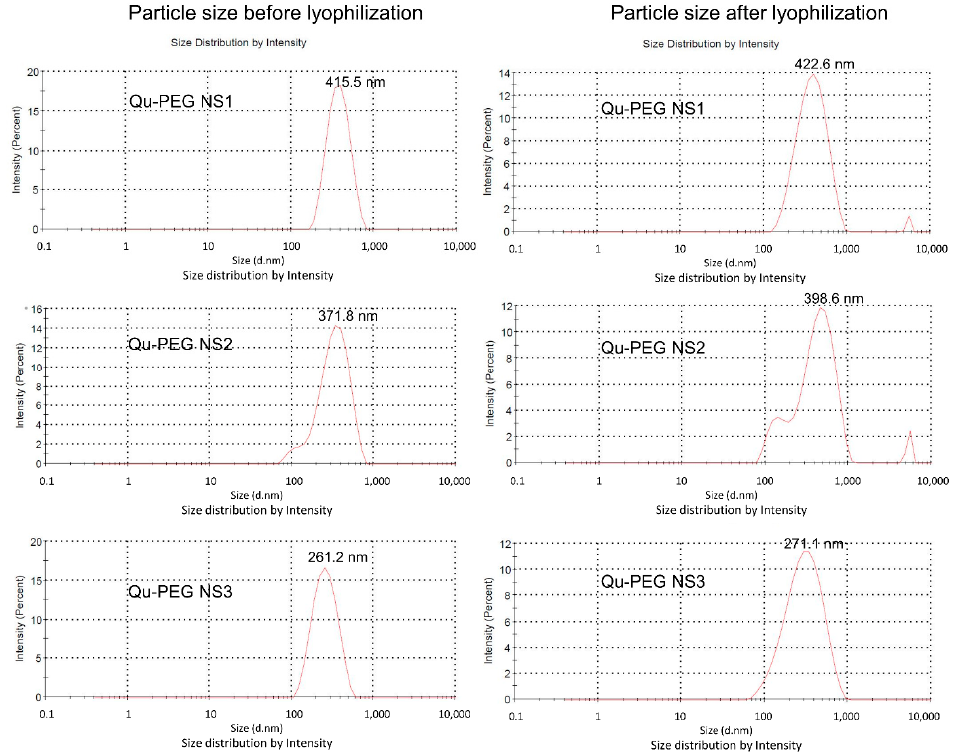
Figure 5. Particle-size distribution of nanosuspensions before and after lyophilization.